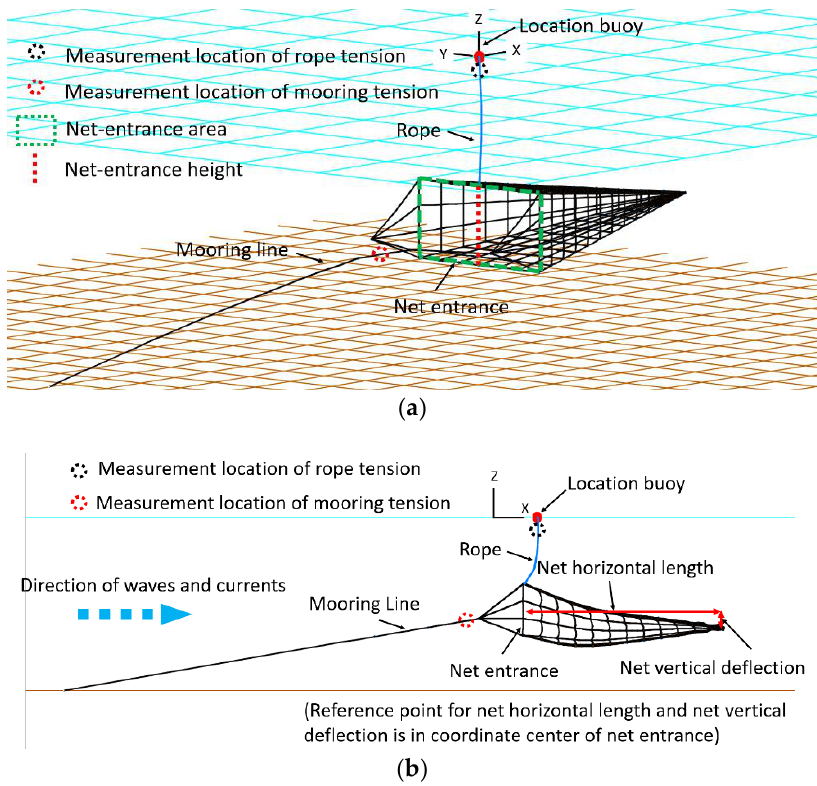
Figure 1. 3D ( a ) and 2D ( b ) views of the stow net and description of all analyzed parameters. Table 1. Material properties and design parameters.